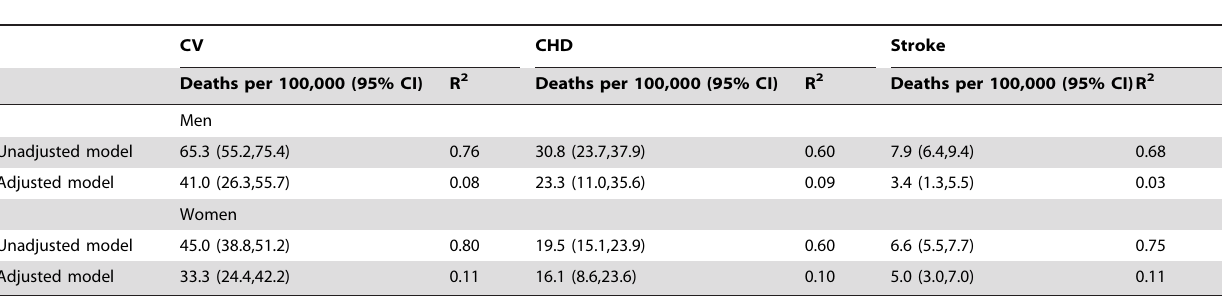
Table 3. Estimated differences in cause-specific state mortality rates in 2010 for US adults aged 45–74 associated with each standard deviation in state CV risk